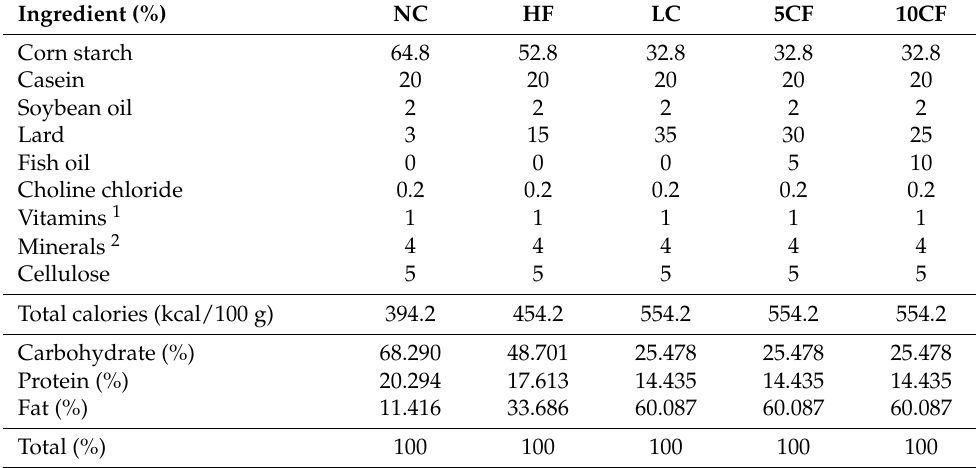
Table 1. Experimental diet